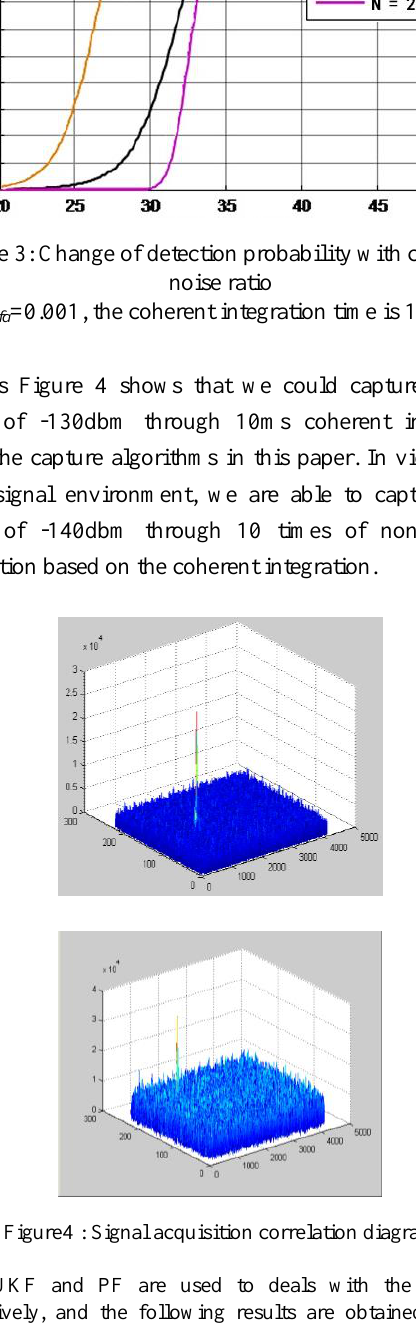
represents the X direction positioning error comparison under three kinds of filter. Figure 6 represents the Y direction positioning error comparison and Figure 7 represents the Z direction positioning error